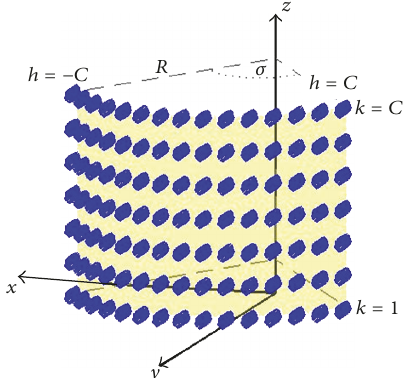
Figure 2: Antenna structure for the first application of the proposed algorithm: cylindrical arc array of quadrifilar helix antennas.